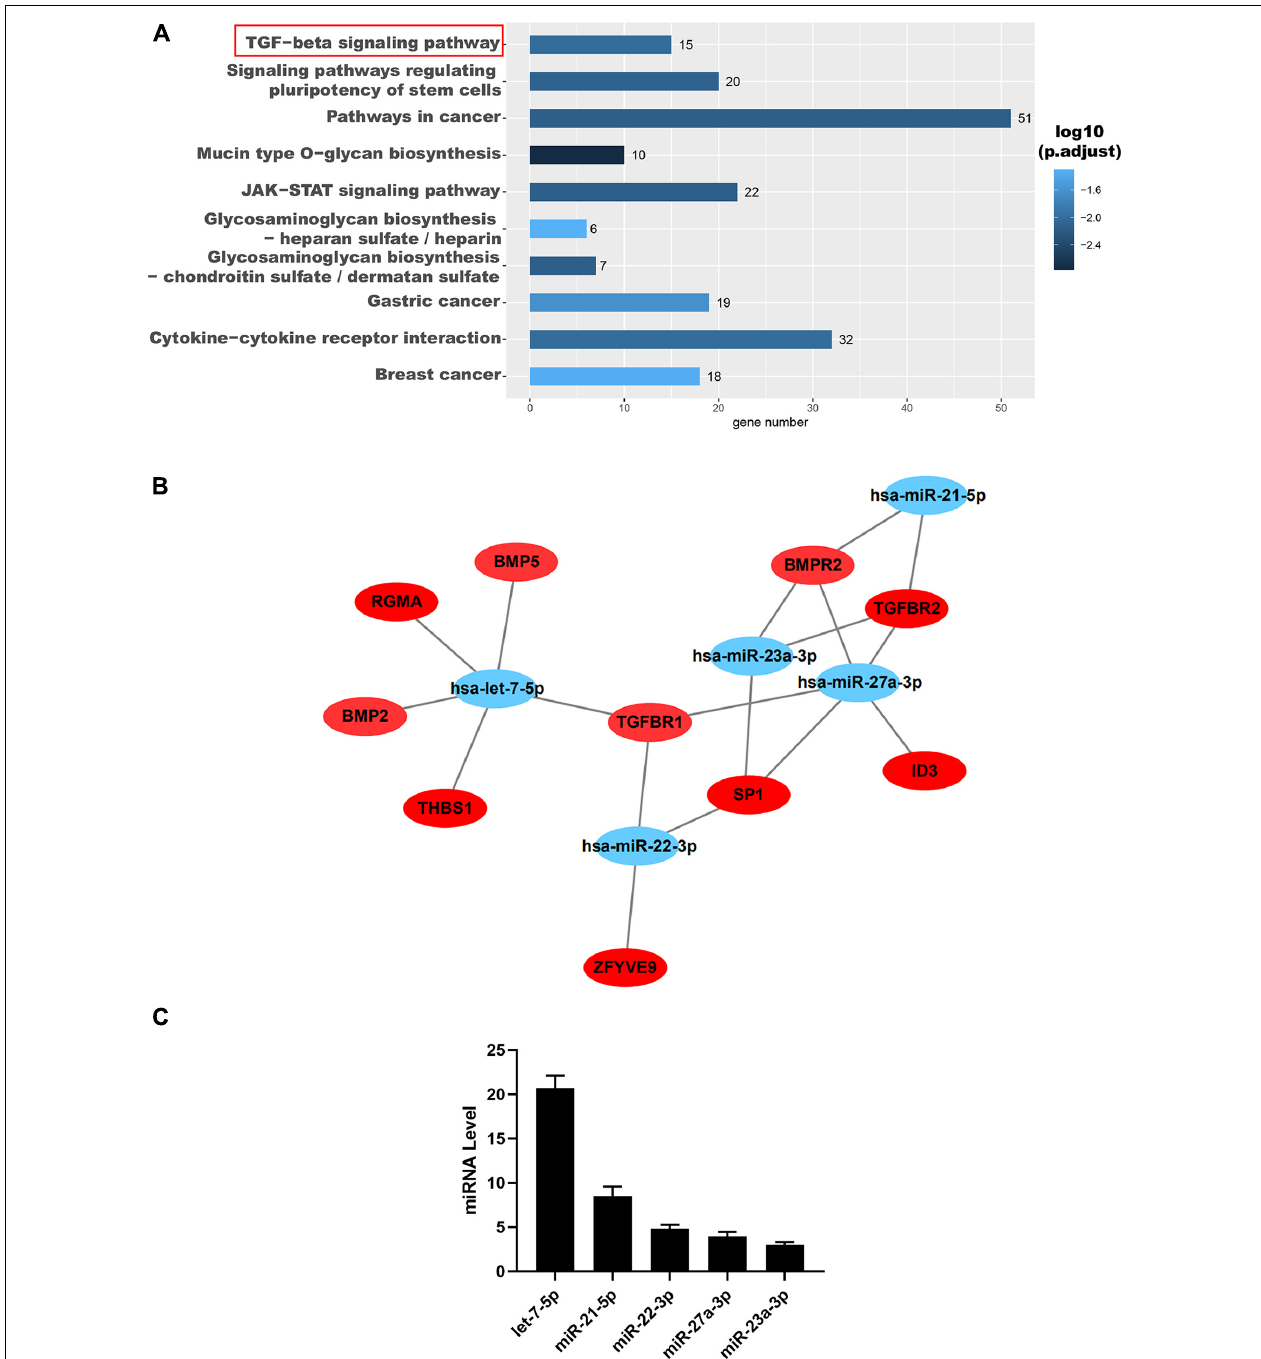
FIGURE 5 | Identification and functional analysis of hAFSC-exo-miRNAs. (A) Target mRNA prediction of hAFSC-exo-miRNAs using Gene Ontology analysis; the TGF- β signaling pathway was highly related to myofibroblast formation. (B) The miRNA–mRNA interaction network of hAFSC-exo-miRNAs and their predicted targets. (C) Primary miRNAs in hAFSC-exo as measured by qRT-PCR